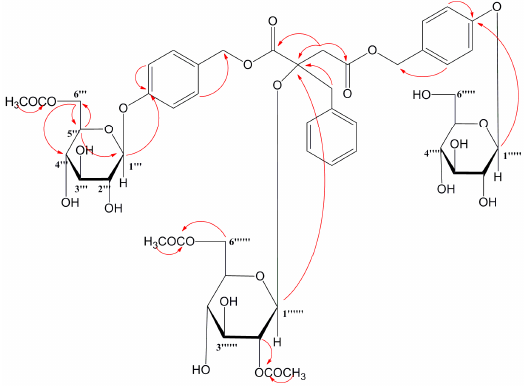
Figure 2. Key HMBC correlations of compound 6.